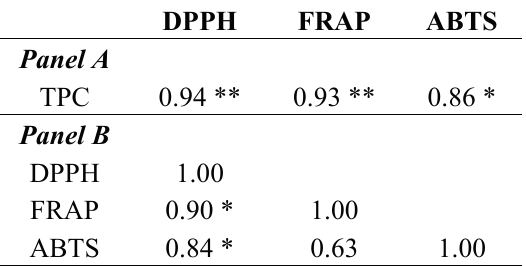
Table 3. Linear correlation coefficients between phenolic content and antioxidant capacity (panel A), and among the different methods for quantifying antioxidant capacity (panel